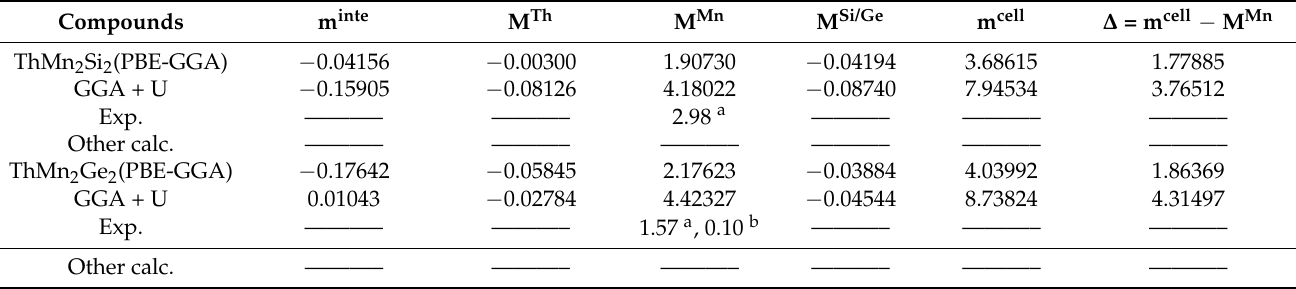
Table 2. Magnetic moments of the interstitial region (m inte ), single atoms ( M Th/Mn/Si/Ge ), and overall cell for the ThMn 2 Si 2 and ThMn 2 Ge 2 compounds computing both schemes (Bohr magnetrons µ B